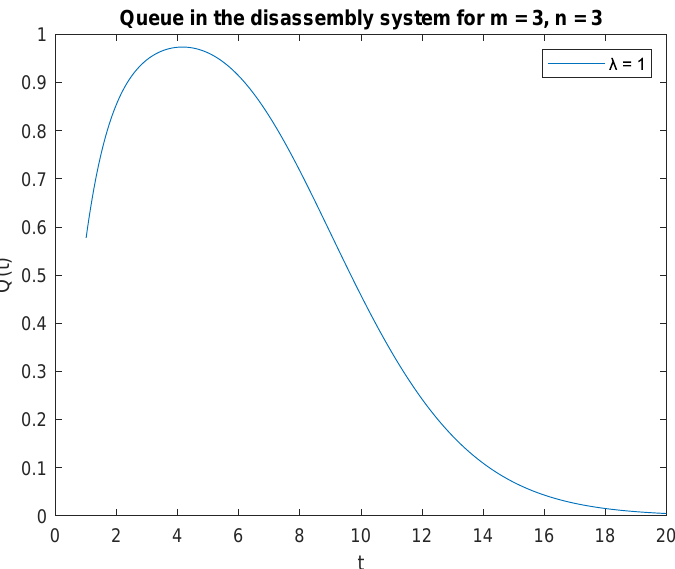
Figure 6. Impact of buffer capacity on probability P { X ( t ) = 3 | X ( 0 ) = 3 } .